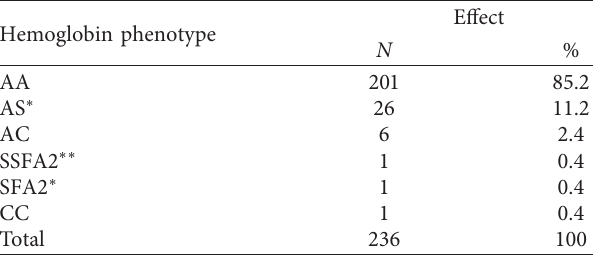
Table 6: Distribution of the population of subgroup 1 according to the hemoglobin